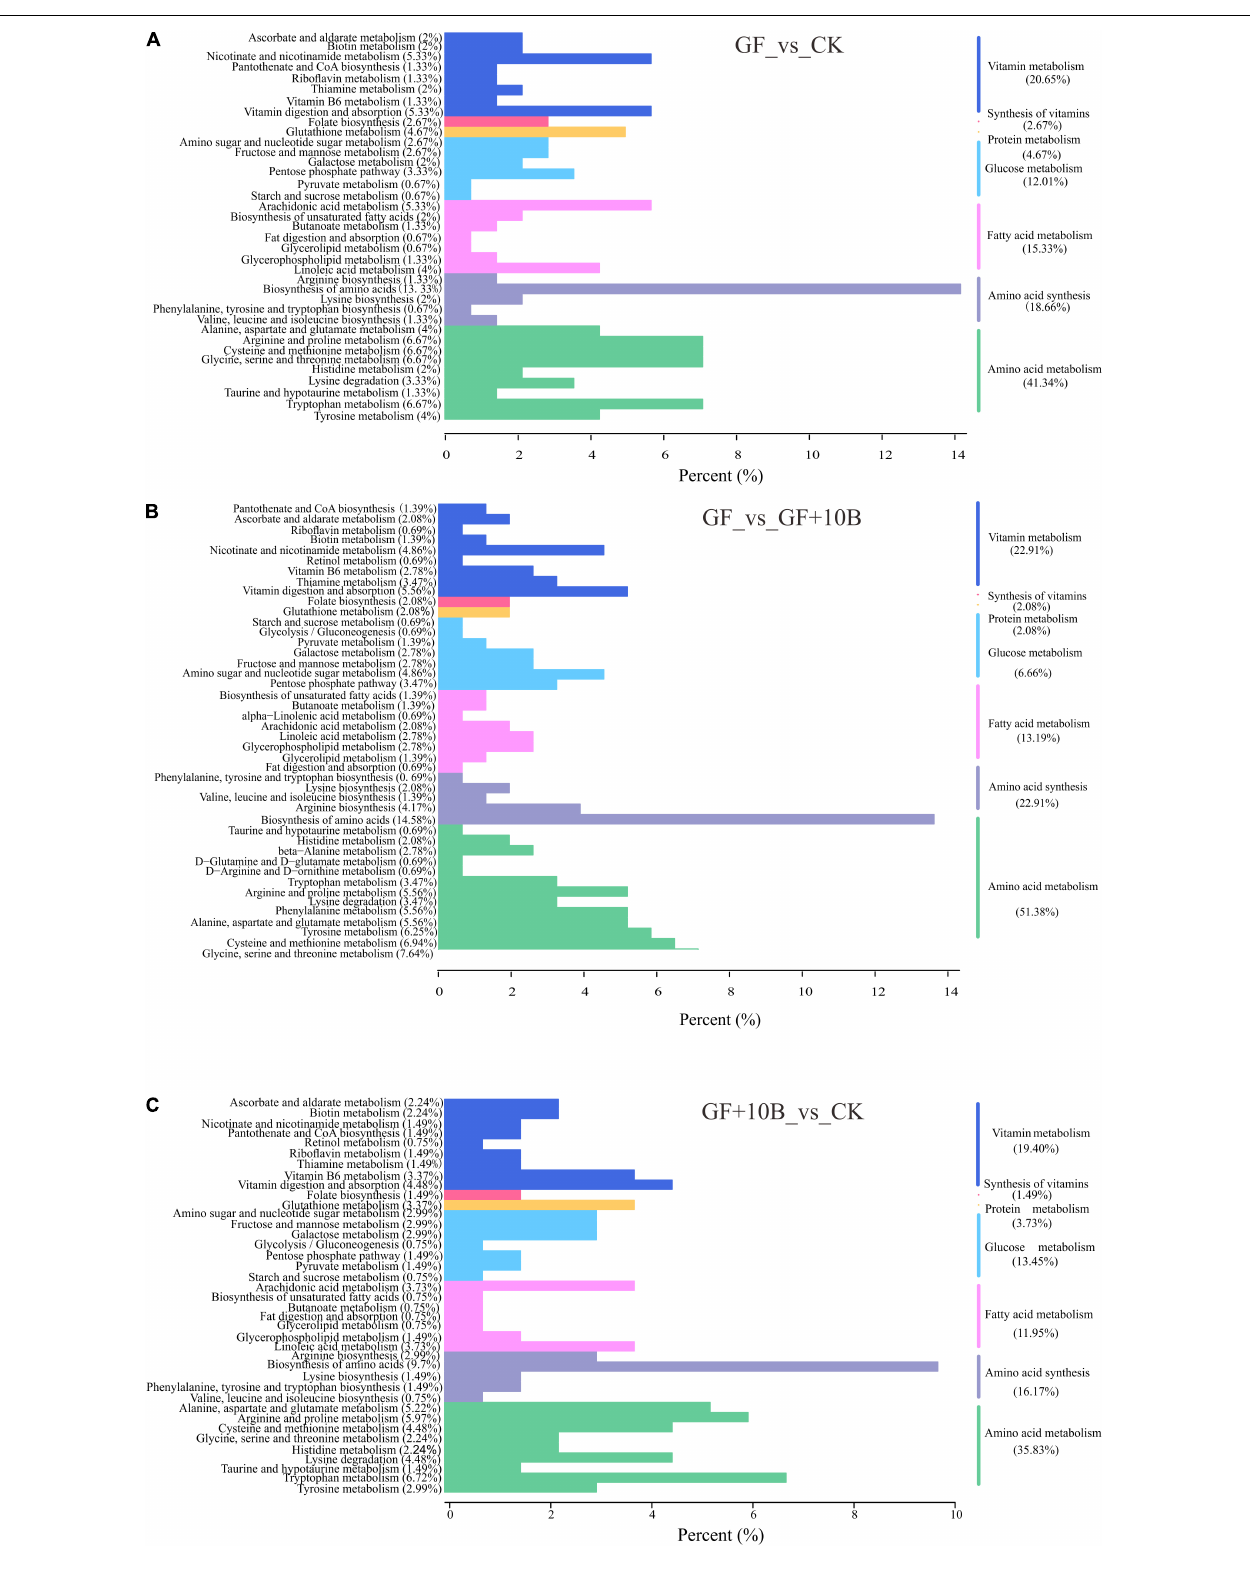
FIGURE 7 | The KEGG enrichment analysis of the DAMs between (A) GF and CK. (B) GF and GF + 10B. (C) CK and GF + 10B. GF, germ-free BSFL fed on sterile food waste; GF + 10B, germ-free BSFL fed on sterile food and 10B; CK, natural BSFL fed on sterile food waste.